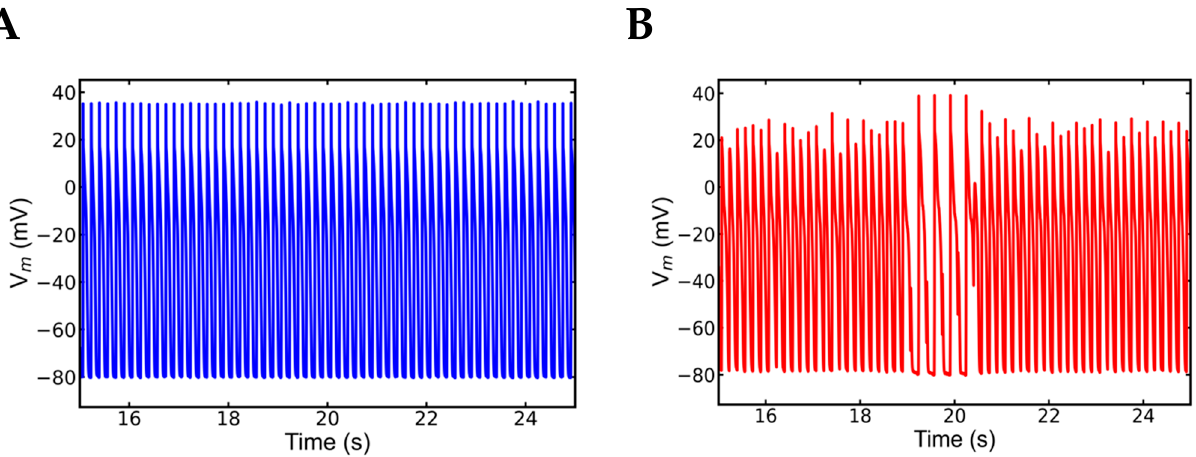
Figure 8. Alternans and alternate beat skipping cause arrhythmia in a myocyte having mutation in the gene expressing CASQ2 protein. ( A ) Simulation of WT myocyte with 6 Hz rapid pacing. ( B ) Arrhythmia observed in the forms of alternans and beat skipping in a mutant myocyte in rapid pacing of 6 Hz simulated with β -adrenergic stimulation. The simulation was repeated 10 times with different seeds for the pseudo random number generator and the patterns observed were repeated each time. Shown here is a representative simulation.